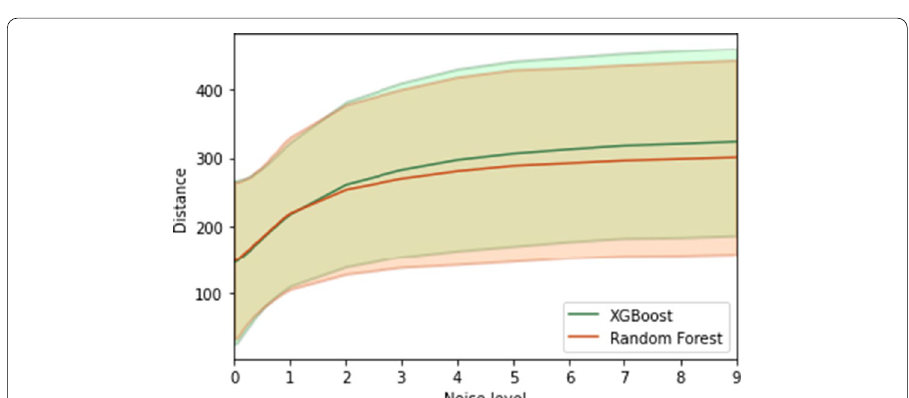
Fig. 16 Noise effects over euclidean distance error for random forest model and gradient boosting